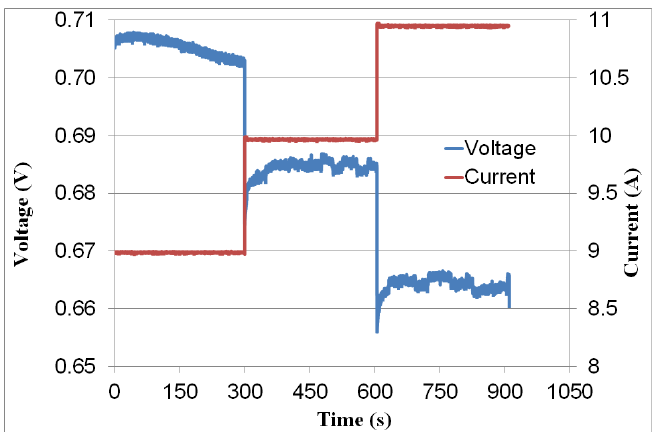
Figure 3. Experimental current and voltage of fuel cell.